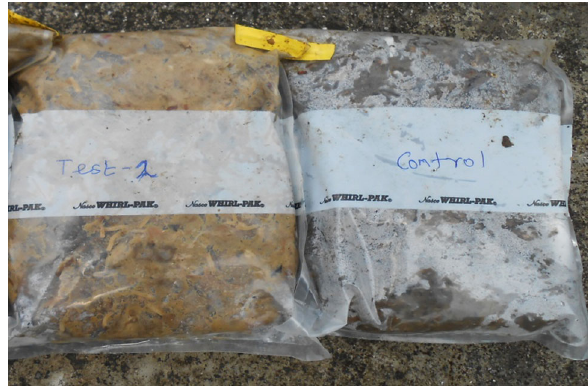
Fig. 6 Determination of colour and texture changes in 30 kg waste after 30 days of degradation